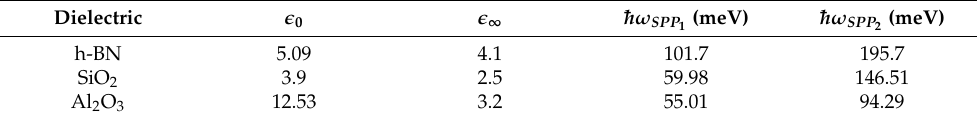
Table 1. Phonon energies and low and high-frequency dielectric constants considered for the different substrates studied in the present work. The values have been taken from